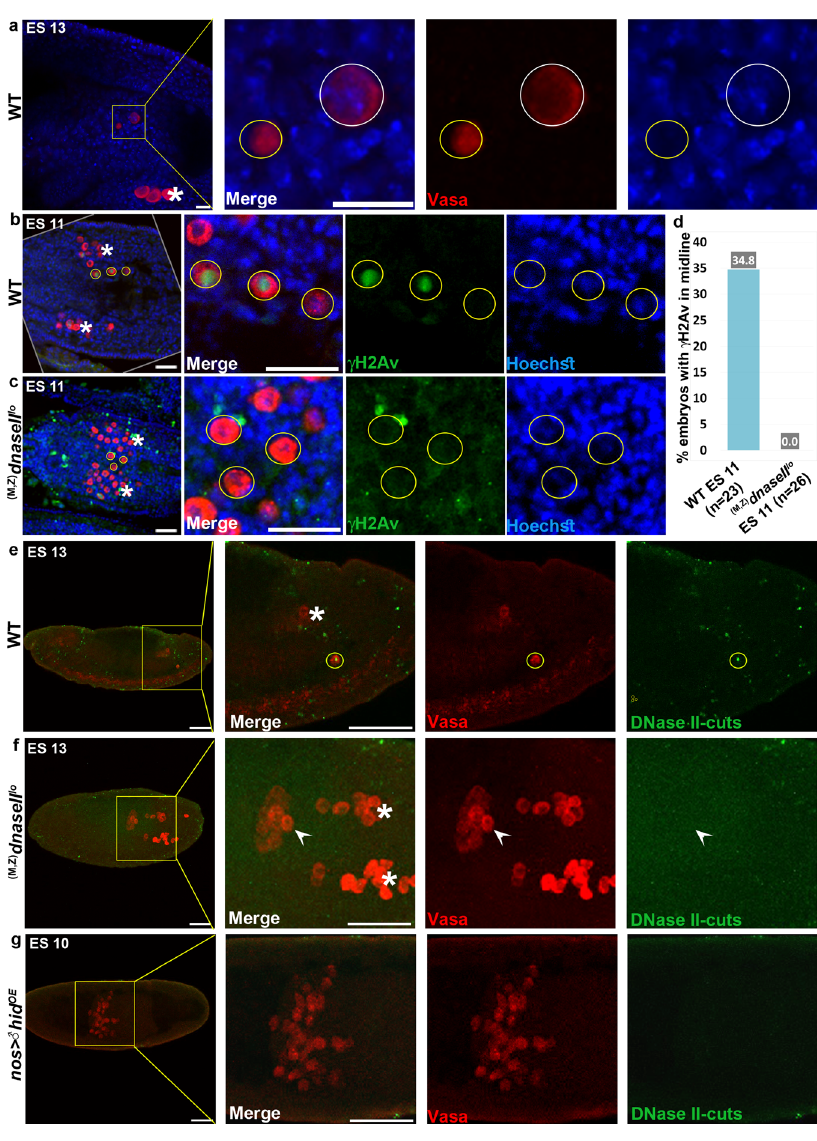
Fig. 5 PGC death is associated with DNase II-dependent DNA breaks. a DNA of dying PGCs becomes highly fragmented. A WT embryo at ES 13 stained to visualize the PGCs (Vasa; red) and the DNA (Hoechst; blue). The area of the midline PGCs is magni fi ed in the right panels. Shown, are two dying midline PGCs during early (white circle) and late (yellow circle) cell death stages. Hoechst is readily detected during the early PGC death stage, and its signal fades away at advanced PGC death stages, typical of extensive DNA fragmentation. The asterisk indicates gonadal PGCs. Scale bars, 10 μ m. b - d Dying PGCs exhibit DNase II-dependent DNA breaks. Images of the midline areas of WT ( b ) and dnaseII mutant ( c ) embryos, at ES 11, stained to visualize phosphorylation of H2Av ( γ H2Av, green; an early event following DSBs), PGCs (Vasa; red), and DNA (Hoechst; blue). Circled are three dying midline PGCs at different cell death stages displaying varying levels of γ H2Av ( b ). In contrast, ectopically surviving midline PGCs in dnaseII mutants displayed no γ H2Av signal (circled in c ). The asterisks indicate gonadal PGCs. Scale bars, 20 μ m. d Corresponding quanti fi cations of the percentage of embryos displaying γ H2Av staining. The percent value is indicated above each column. n , number of examined embryos. e – g Developmentally dying PGCs, but not ectopically surviving dnaseII mutant PGCs or dying apoptotic PGCs, exhibit DNase II-type DNA breaks. Representative images of WT ( e ) and dnaseII mutant ( f ) embryos, at ES 13, as well as an ES 10 embryo with PGC-speci fi c OE of hid ( g ), all labeled by a Top I-mediated ligation assay to visualize DNase II-type DNA cuts (green). PGCs (Vasa; red). The outlined areas (yellow squares) are magni fi ed in the right panels. Circled, is a dying PGC positively labeled for DNase II-type DNA cuts. An arrowhead is pointing at unlabeled ectopically surviving PGCs. Asterisks indicate gonadal PGCs. Note that Hid-induced